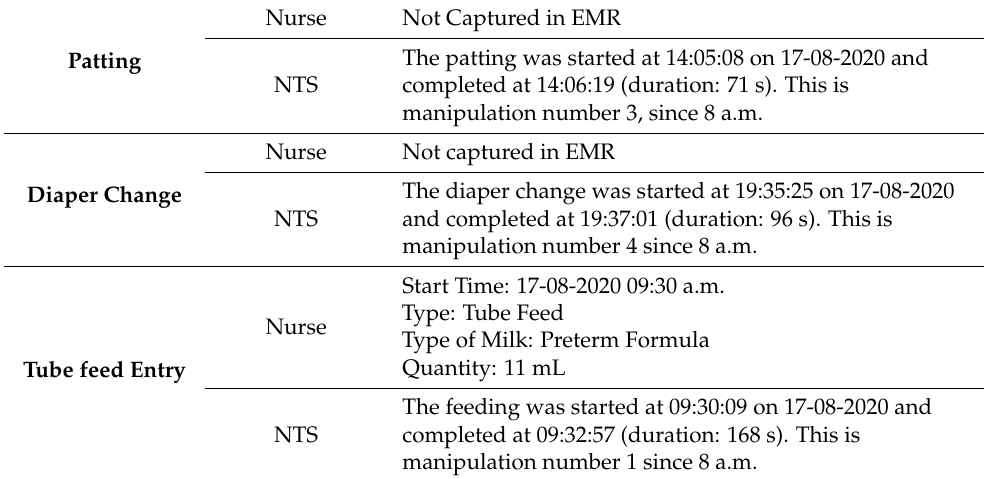
Table 4. NTS generated note of neonatal manipulations.